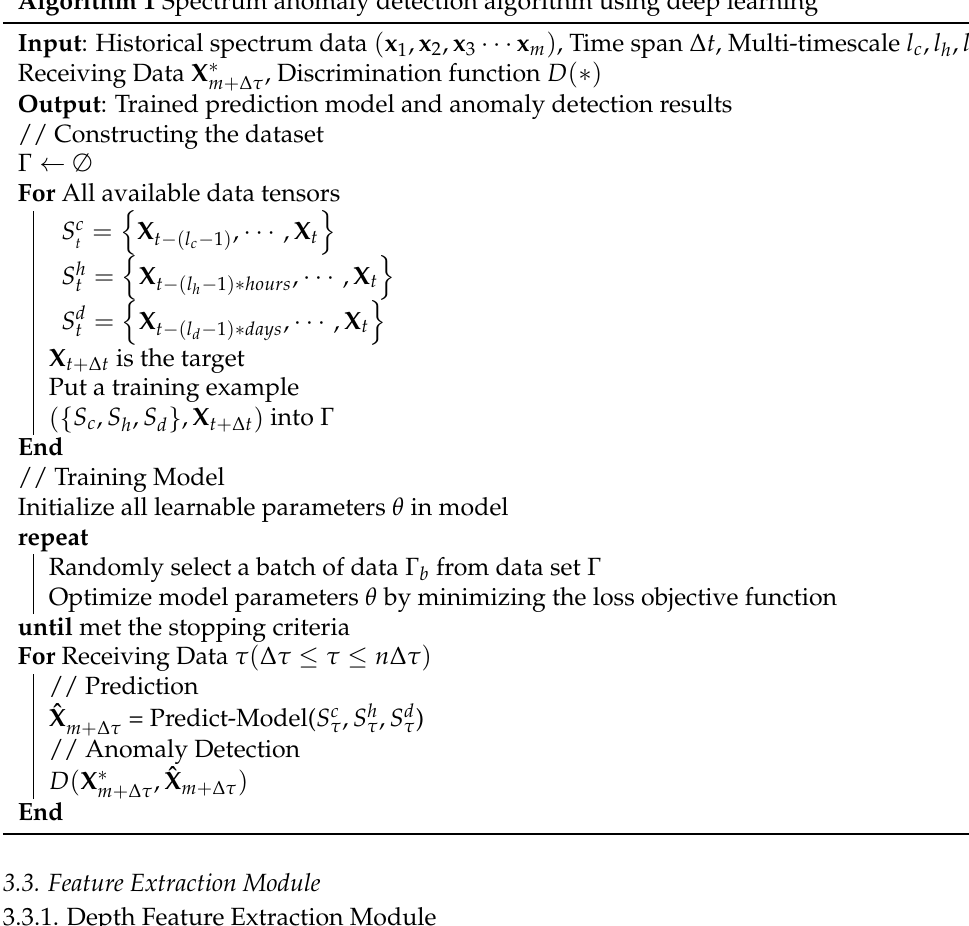
Algorithm 1 Spectrum anomaly detection algorithm using deep